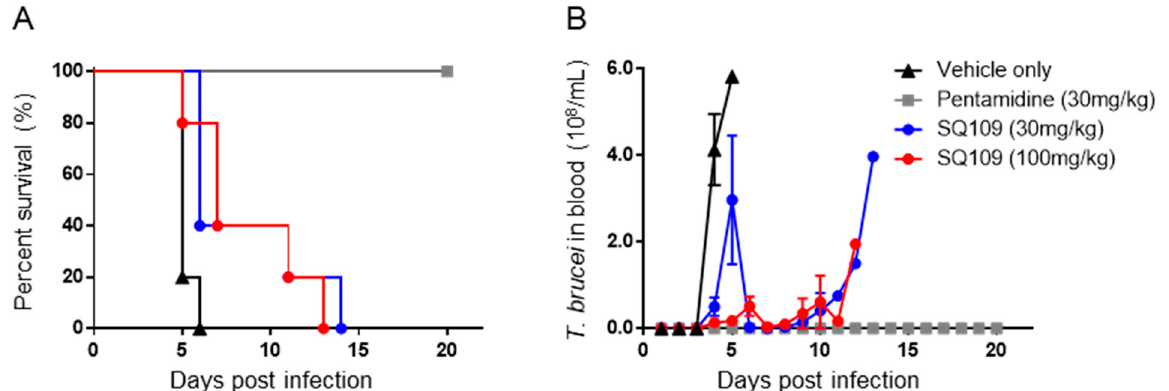
Figure 3. Efficacy of SQ109 in acute T. brucei mouse model. ( A ) Survival and ( B ) number of T. brucei parasites in the bloodstream of T. brucei infected BALB/c mice treated with vehicle only [ ▲ ], pen- tamidine (30 mg/kg) [ ■ ], SQ109 (30 mg/kg) [ ● ] or SQ109 (100 mg/kg) [ ● ]. ( n = 5).